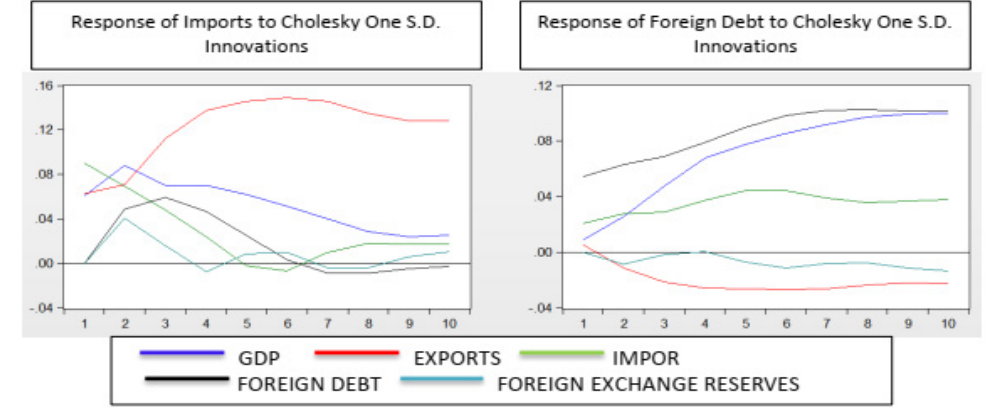
Figure 3: IRF Graphics of Response Imports and Foreign